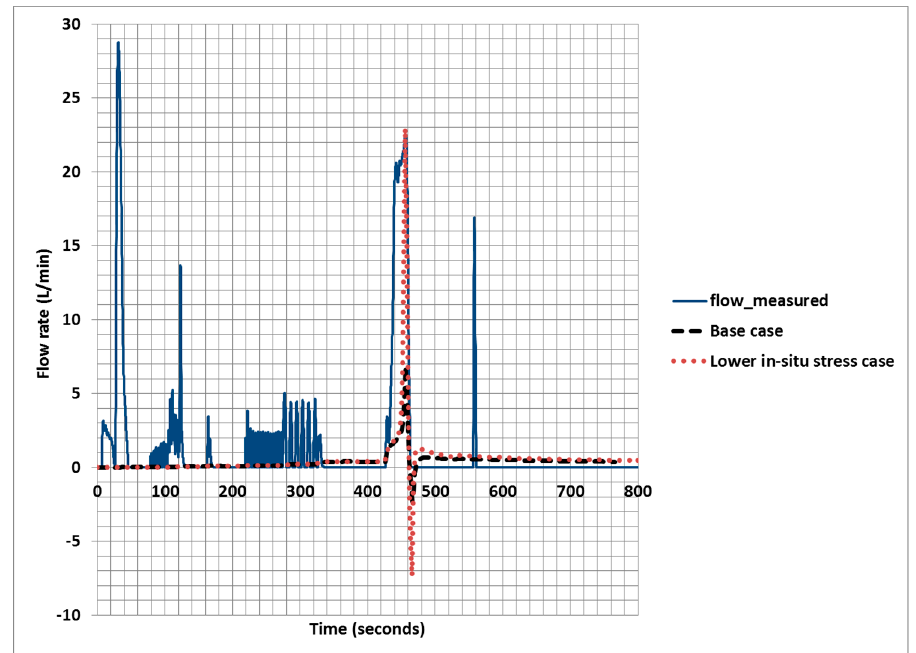
Figure 15. Effect of lower in-situ stress on injection flow rate. Figure 15. E ff ect of lower in-situ stress on injection flow